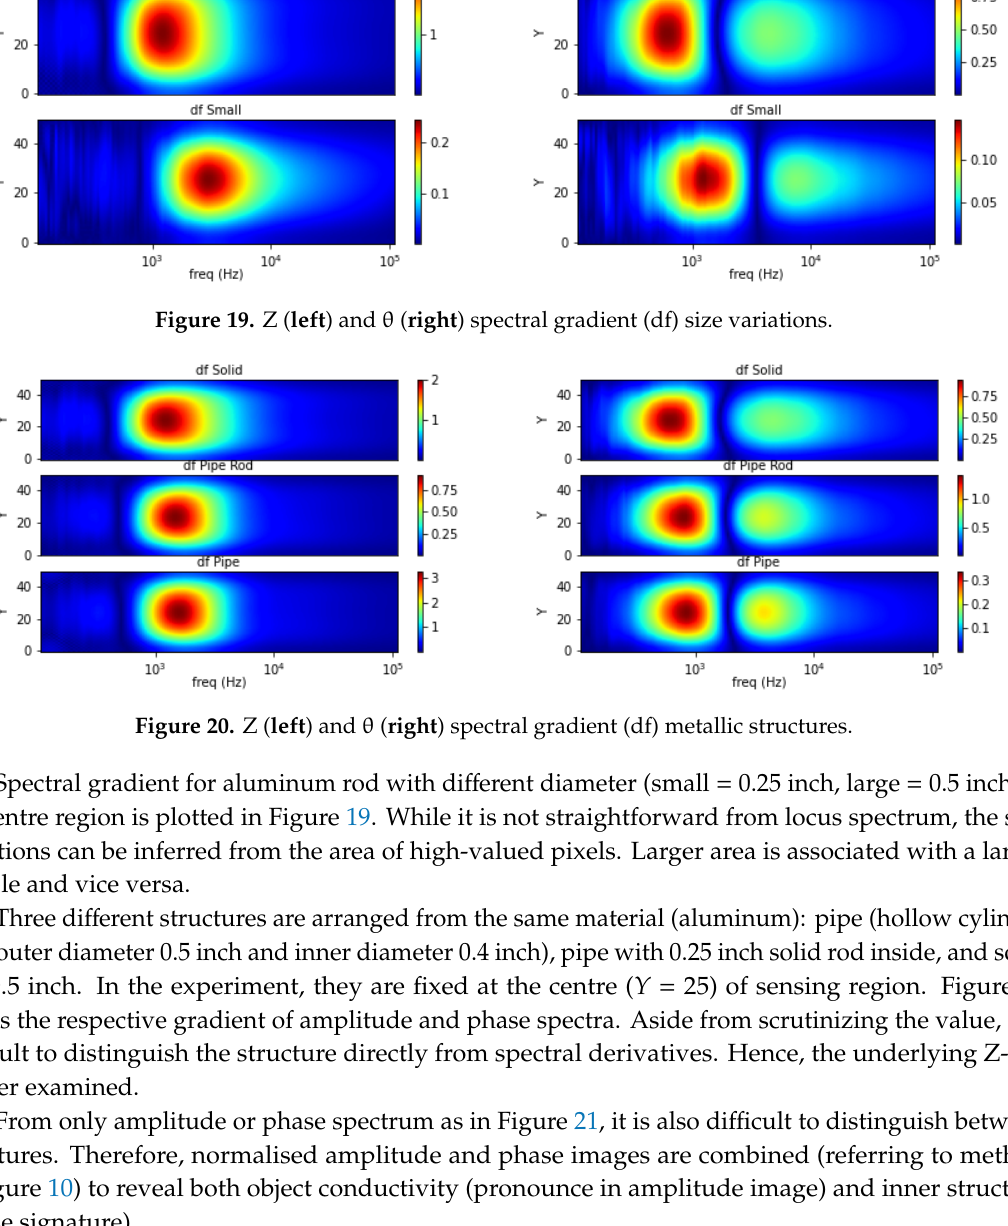
Figure 19. Z ( left ) and θ ( right ) spectral gradient (df) size variations.